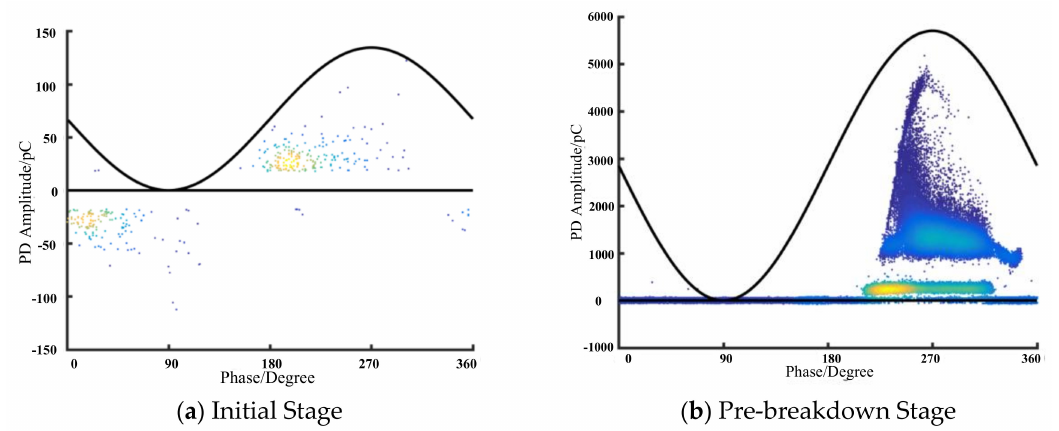
Figure 6. PRPD patterns under AC/DC proportion of